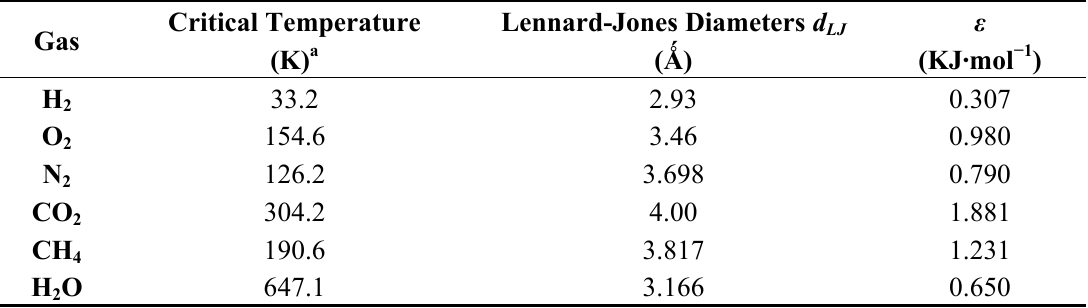
Table 2. Physical properties of six permanent gases used in the experimental and theoretical